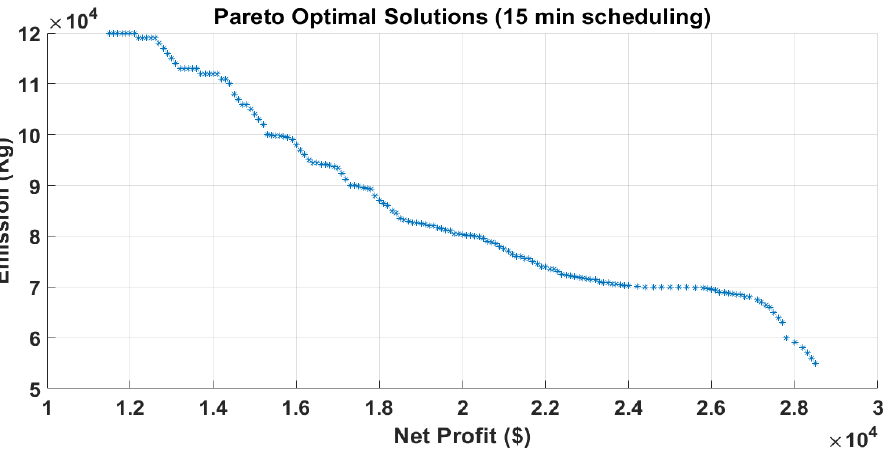
Figure 23. Pareto optimal solutions for Case III of Scenario II (proposed MOBWO technique).